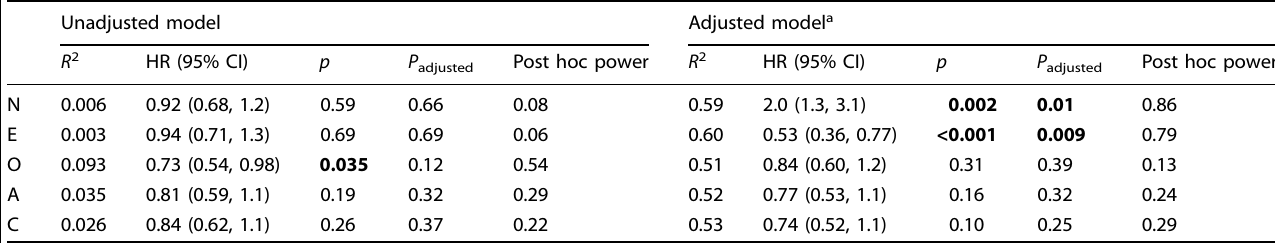
Table 4. Risk of neurodegenerative disorders by personality traits in iRBD patients. Unadjusted